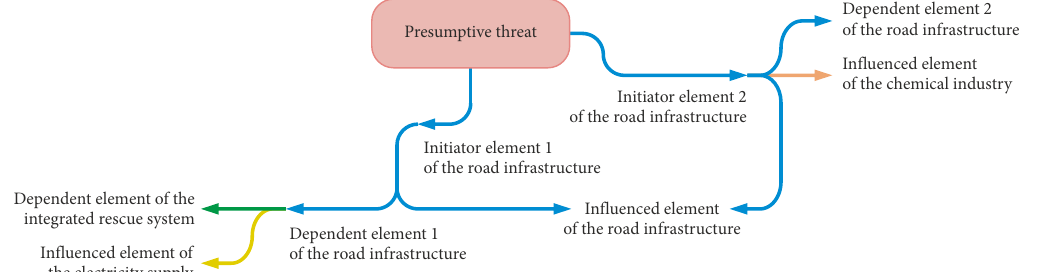
Figure 4. General depiction of a structural map of the spread of cascading impacts